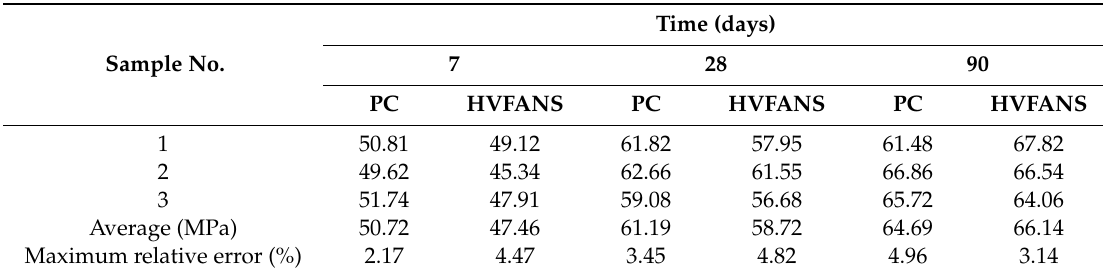
Table 2. Curing age e ff ect on the response of plain concrete (PC) and high-volume fly ash concrete with nano-silica (HVFANS) concrete at 25 ◦